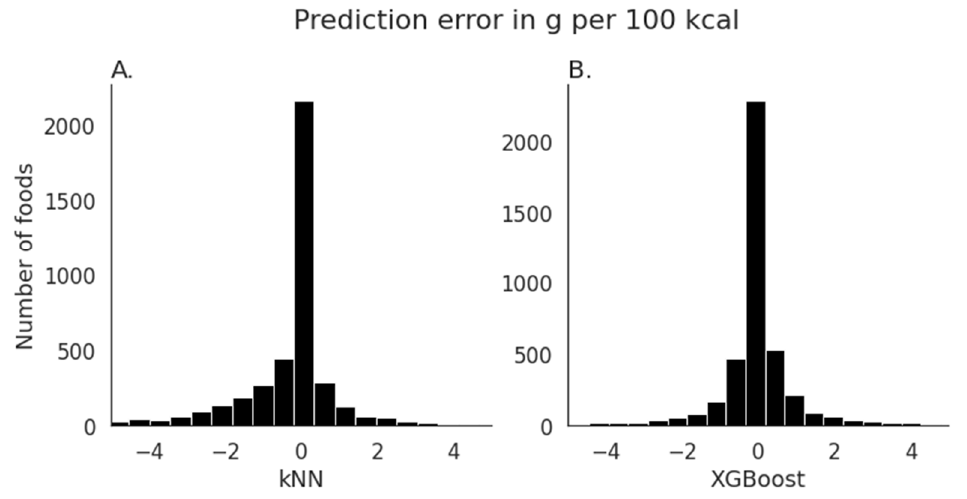
Figure 1. Error in the prediction of added sugar values in g per 100 kcal. ( A ) When using the kNN algorithm for estimation, errors skew towards more errors being < 0 g, indicating that the model tends to underestimate added sugar content. The mean absolute error is 1.19 g. ( B ) When using the XGBoost algorithm for estimation, errors are roughly symmetrically distributed around 0 with a slight bias towards overestimating added sugar content. The mean absolute error is 0.81 g.